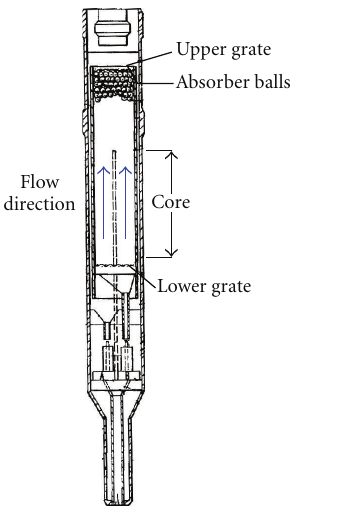
Figure 1: Conceptual drawing of the hydraulically suspended ab- sorber ballssecondary SCRAM system [1, 2].